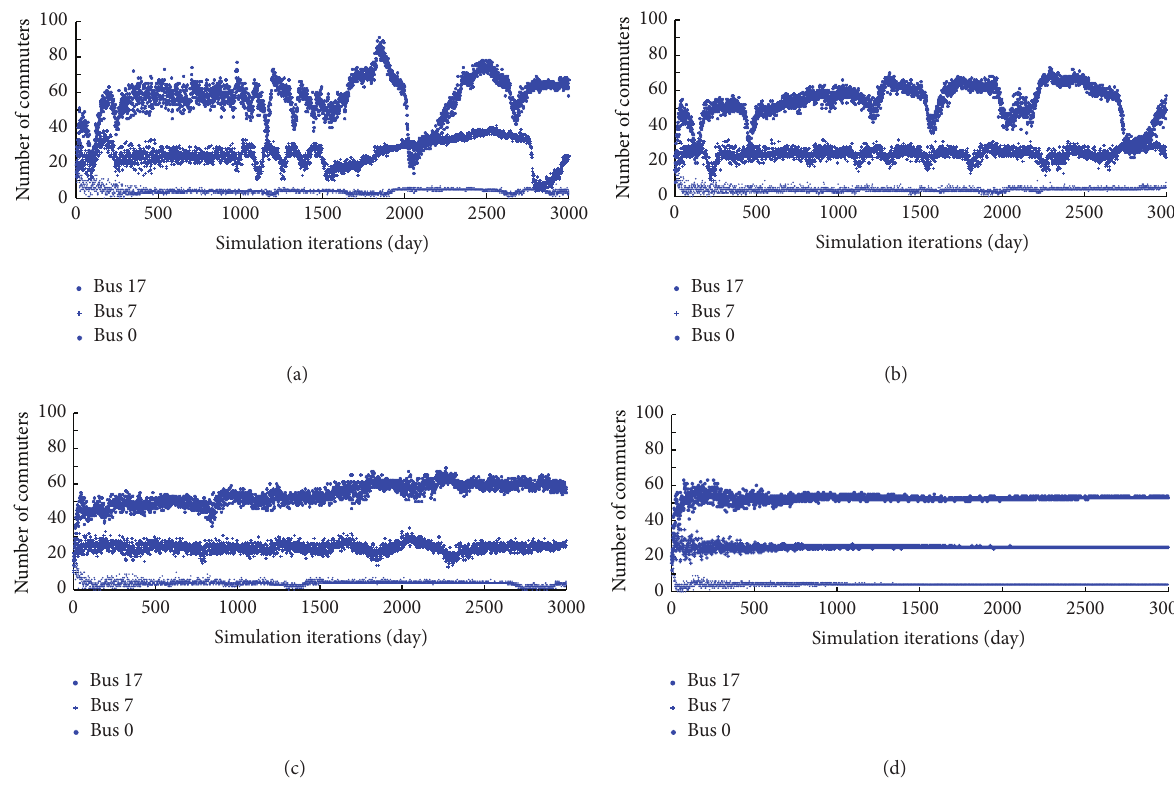
Figure 17: Number of commuters on some typical buses. ((a) Short-term memory experiment, (b) middle-term memory experiment, (c) long-term memory experiment, and (d) verification